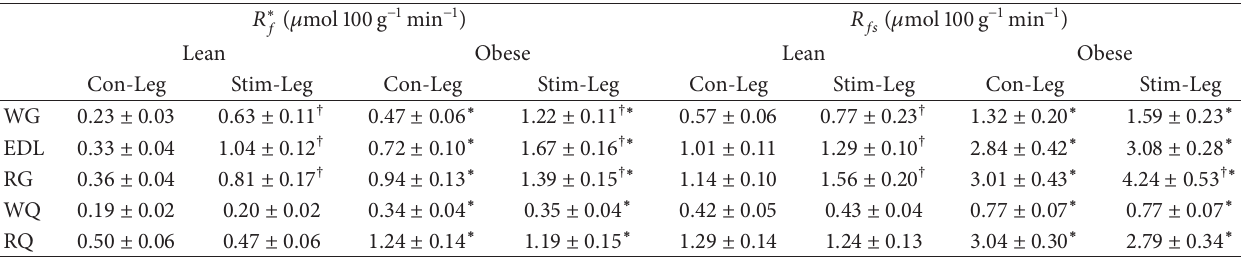
Table 5: 𝑅 ∗ 𝑓 and 𝑅 𝑓𝑠 in individual hind leg muscles in lean and obese Zucker rats.